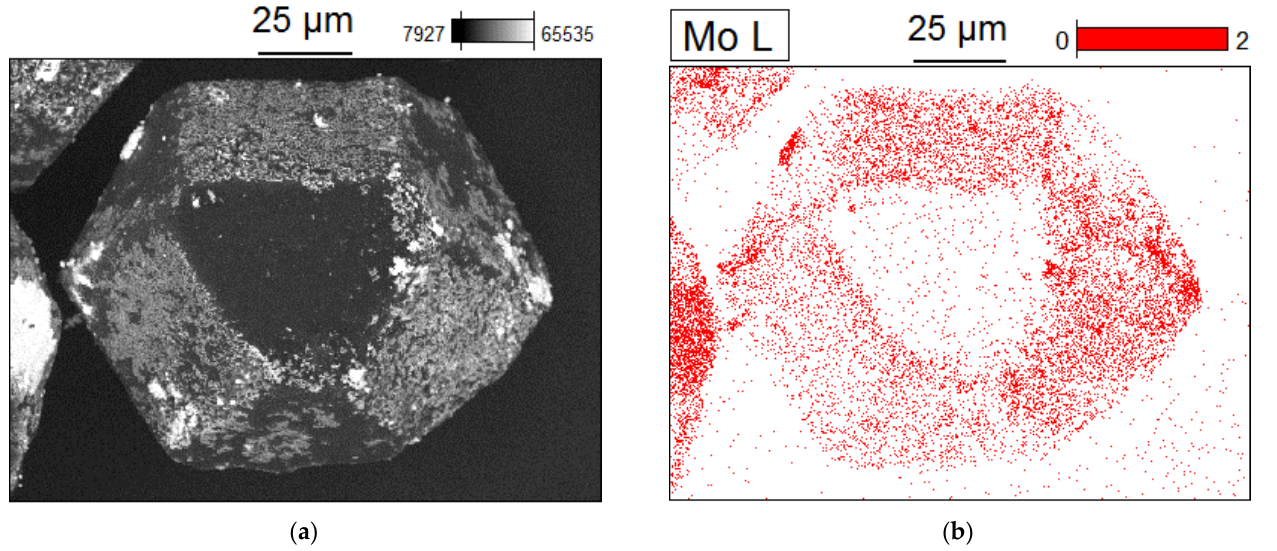
Figure 10. XRD patterns of the samples obtained at 1000 °C.